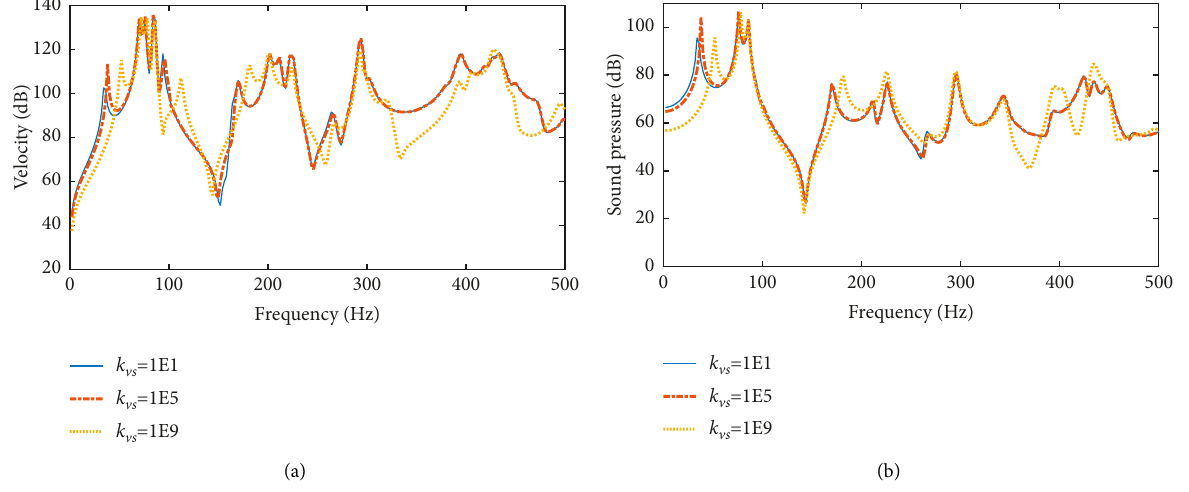
Figure 13: Vibration velocity response at the point on the surface of panel 2 and sound pressure response at the point in the acoustic cavity a with different k vs : (a) vibration velocity response and (b) sound pressure